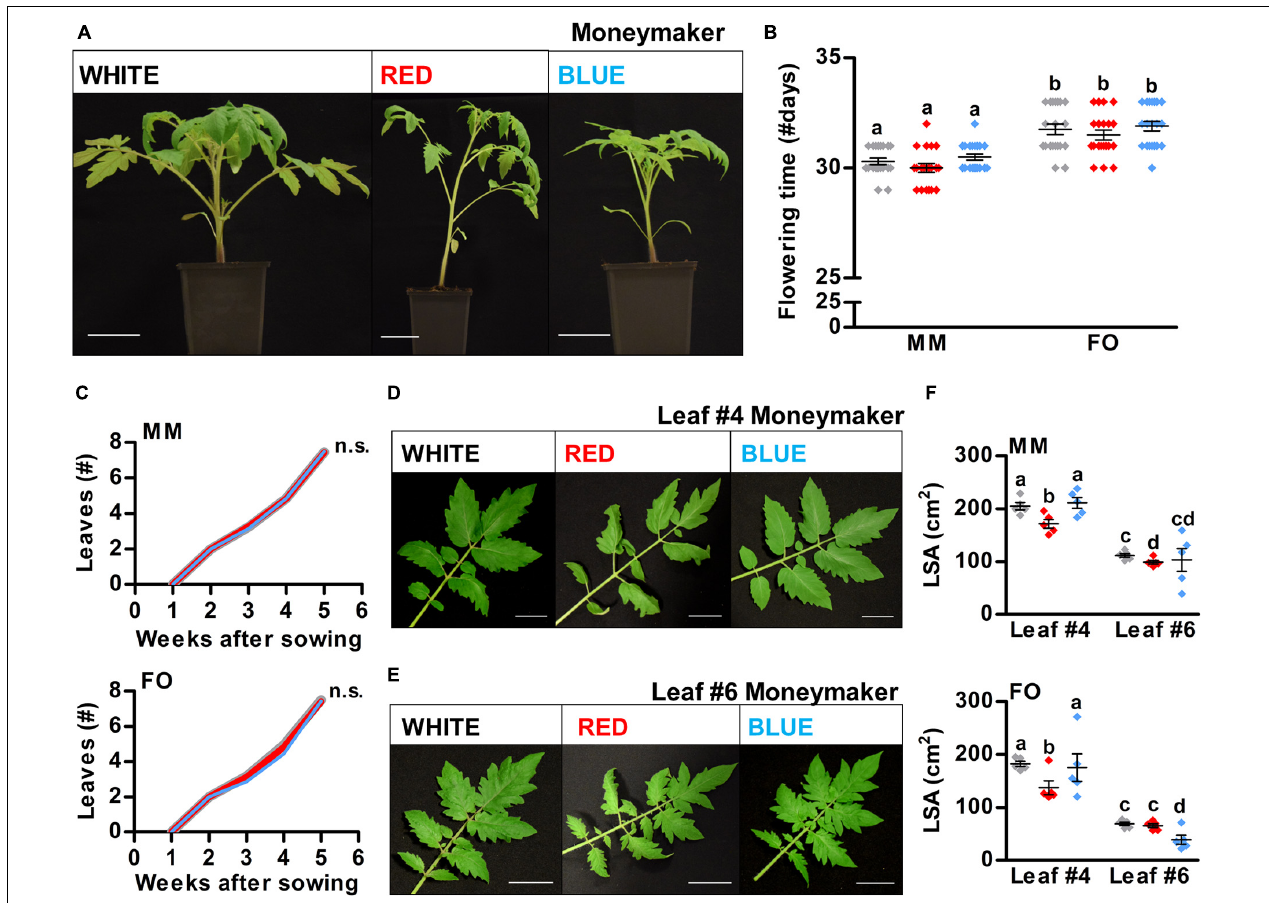
FIGURE 5 | Developmental phase transitions in tomato are indifferent to R/B light ratios. (A) Representative tomato plants of cultivar Moneymaker (MM) grown in white, red, or blue LED conditions until 30 days after sowing (DAS). (B) Flowering time of MM and Foundation (FO) plants in number of days. (C) Leaf appearance over time in MM and FO plants. (D,E) Representative compound leaves from MM plants grown in LED conditions until 45 DAS: leaf #4 (D) and leaf #6 (E) . For presentation purposes, leaves were removed, flattened, and placed on black paper. (F) Quantification of leaf surface area (LSA) of MM and FO leaves shown in ( D,E , and Supplementary Figures S5B,C ), respectively. Scale bars represent 5 cm in (A,D,E) . Graph colors represent the LED conditions in (B,C,F) . LED conditions and cultivars were compared using a one-way ANOVA followed by a Tukey’s test (letters a–d indicate statistically significant differences, p < 0.05) in (B,F) . In (C) , monochromatic LED conditions (red or blue) were compared to white (control) using a two-sided Student’s t -test [n.s. indicates no significant differences between LED conditions ( p < 0.05)]. Error bars represent standard error of the mean in (B , F) ( n = 20), standard errors for (C) are listed in Supplementary Table S2 ( n = 20). Similar results were obtained in two independent